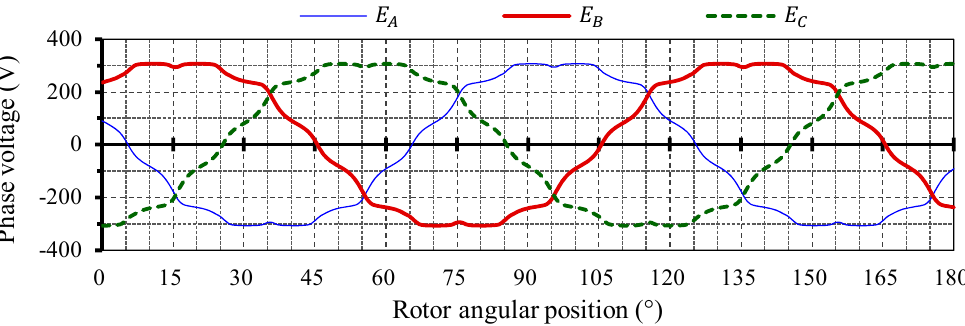
Figure 12 shows the phase-to-neutral no-load voltages. The shape of these voltages are typical of this kind of generator, being almost trapezoidal. The inflection points (e.g., 75 ◦ ) are due to a slot opening that reduces the air-gap flux under its area. The THD of this curve is 7%.